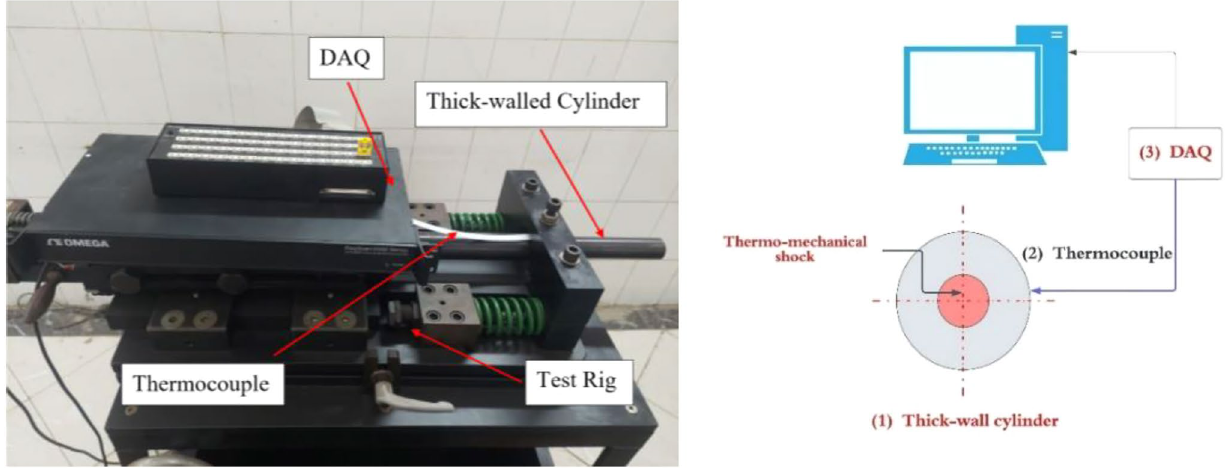
Fig. 17 Schematic drawing of the experimental